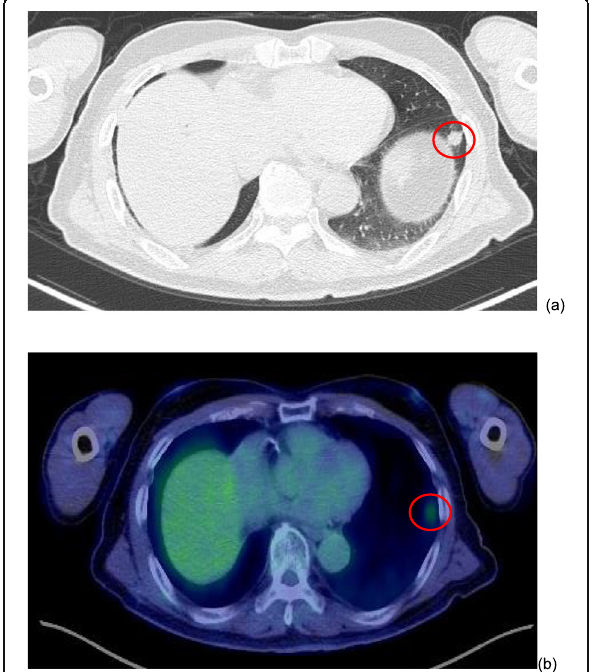
Fig. 3 Computed tomography (CT) and positron emission tomography (PET) show a 10 × 10-mm tumor in the left lung S8 ( a ). This was a new isolated, localized, and solid lesion. Lung cancer metastasis was suspected but pleural indentation was also present, suggesting the possibility of primary lung cancer. PET shows strong uptake of fluorodeoxyglucose at the same site, suggesting lung metastasis ( b )